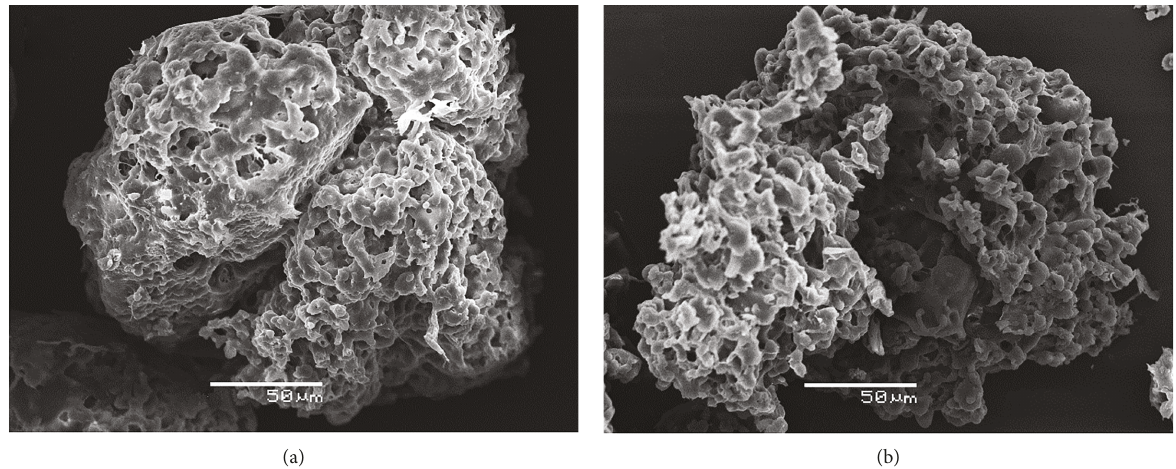
Figure 8: SEM image of the surface morphology of loaded CS microparticles encapsulated in PAA-PVP complexes: (a) PVP-29 and (b) PVP-360.